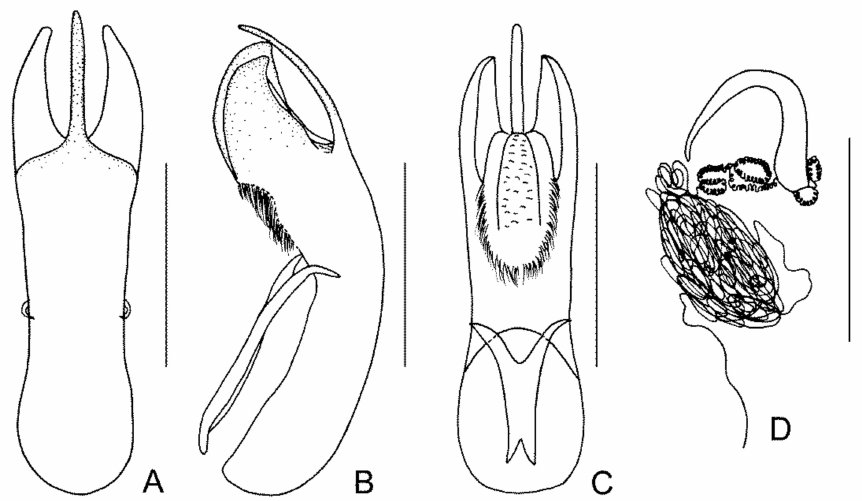
Figure 18. Cryptocephalus ( Burlinius ) flavolimbatus Pic, 1920: ( A ). dorsal view of aedeagus; ( B ). lateral view of aedeagus; ( C ). ventral view of aedeagus; ( D ). spermatheca. (Scale bars: 0.5